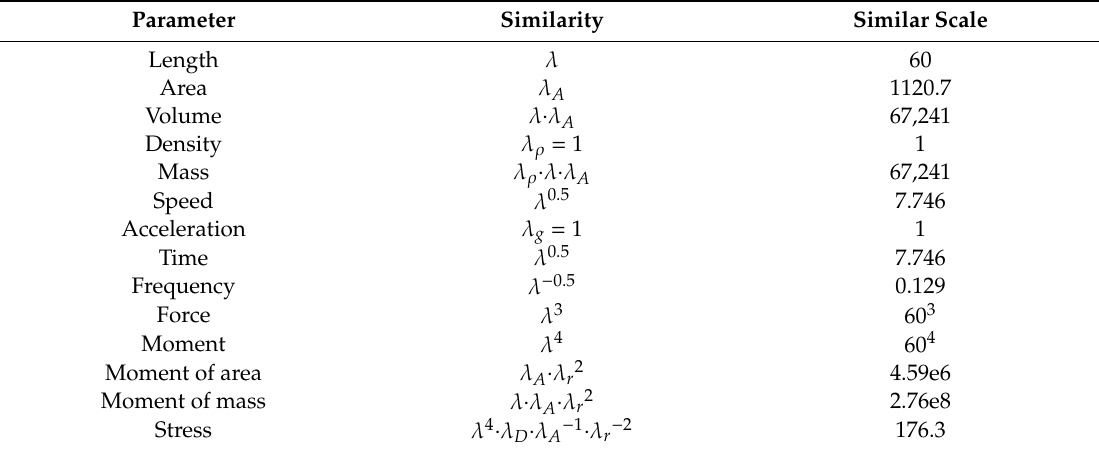
Table 1. The similarity relation of basic parameters for the experimental model design.